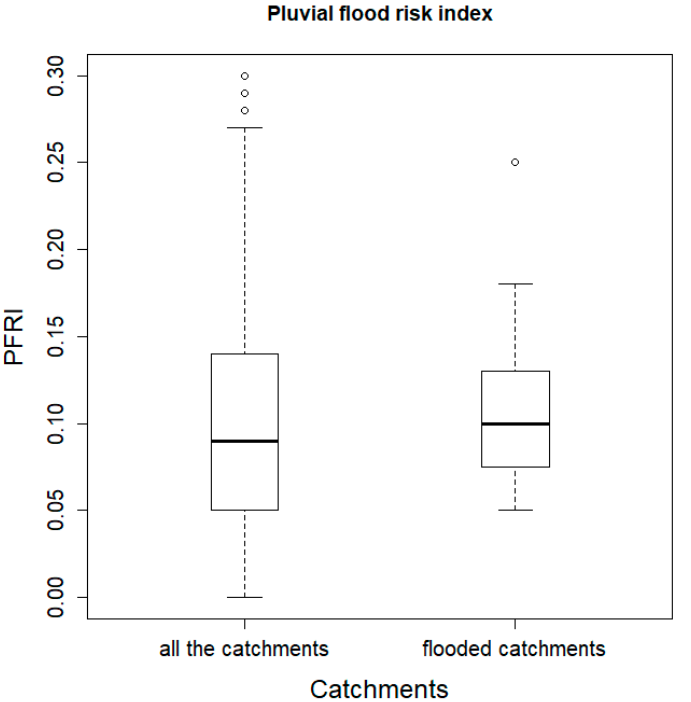
Figure 10. Boxplot of the PFRI values for all the catchments and the flooded catchments.